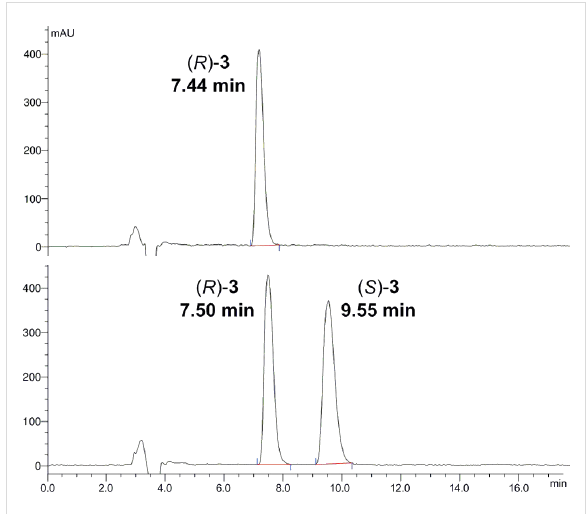
Figure 2: Determination of the optical purity for ( R )- 3 by chiral HPLC on a Daicel AD-H column. Top: Optically enriched product (er > 99:1). Bottom: Racemic